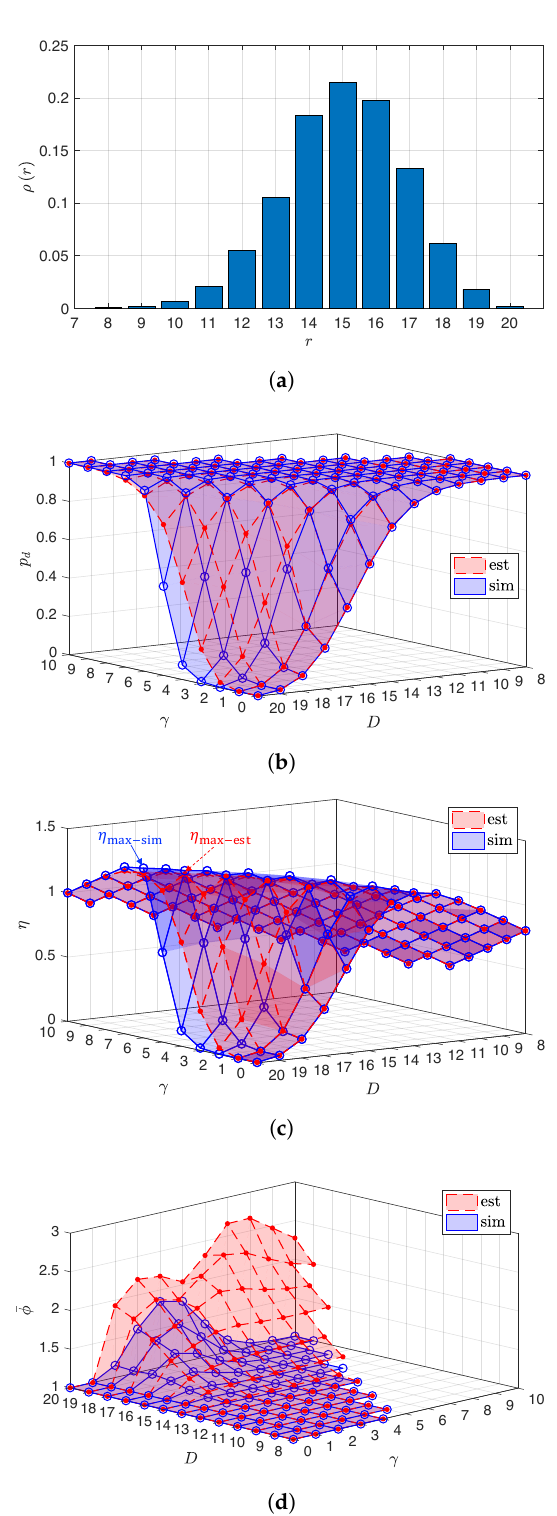
Figure 8. Comparison between the estimated p d and η (est) and the result from the simulation (sim) that were obtained from an empirical rank distribution ρ ( r ) . ( a ) Empirical rank distribution ρ ( r ) ; ( b ) decodability; ( c ) channel efficiency; ( d ) mean length of